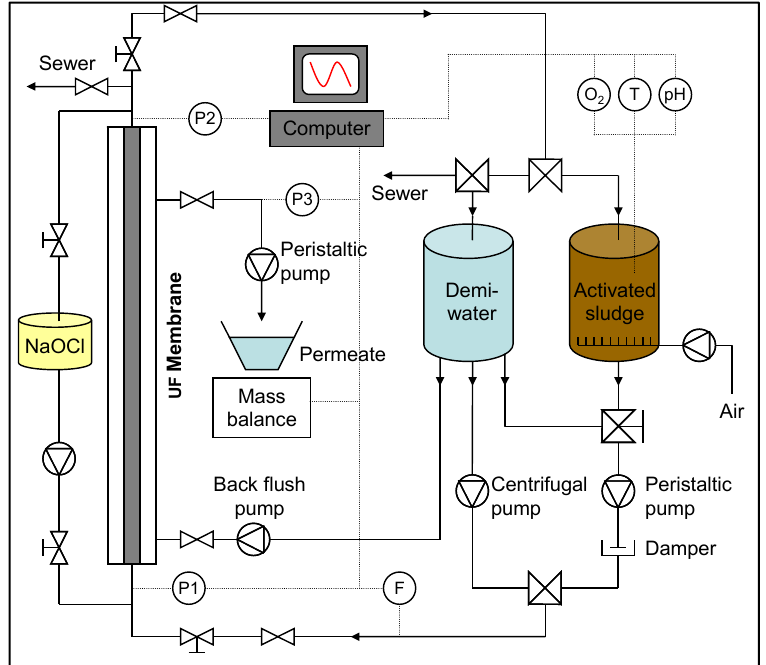
Figure 1. Scheme of the Delft Filtration Characterization Installation (DFCi) [4]. Reprinted with permission from [4]. Copyright 2010 Delft University of